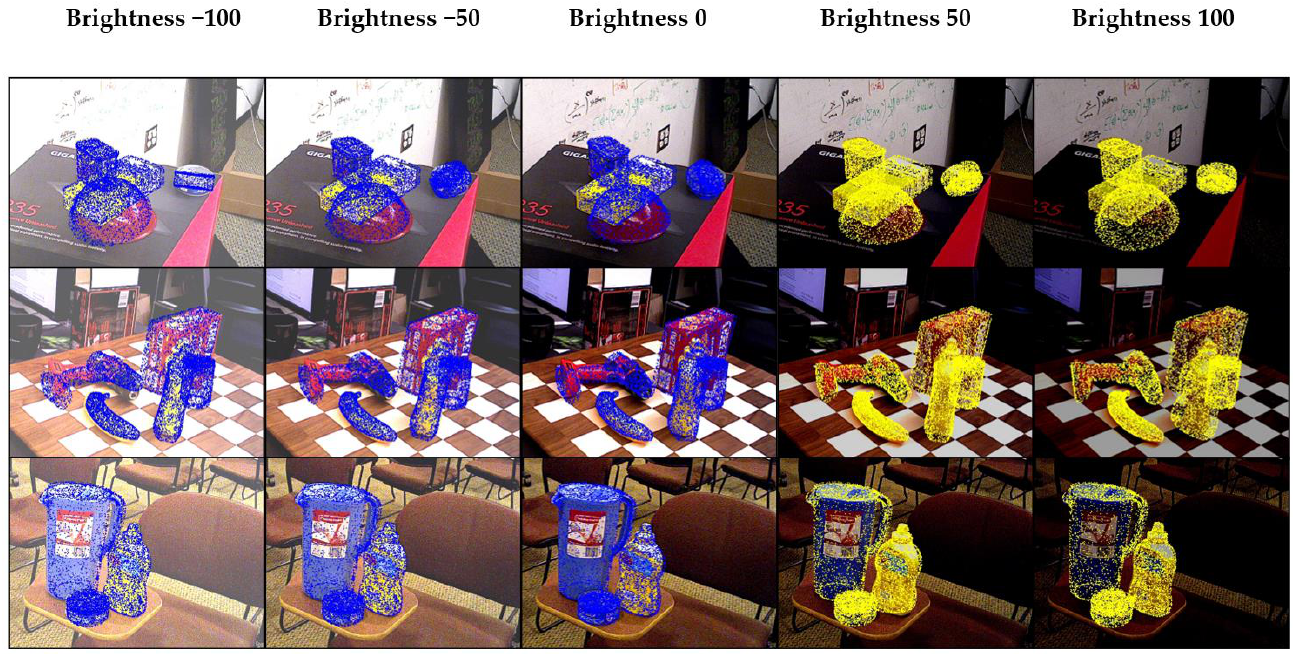
Figure 7. Visualized results of our method on the YCB-Video Dataset when lighting condition changes.